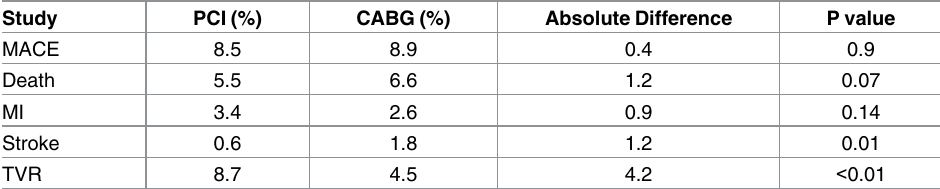
Table 3. One year rate of clinical events (P refersto pooled OR).